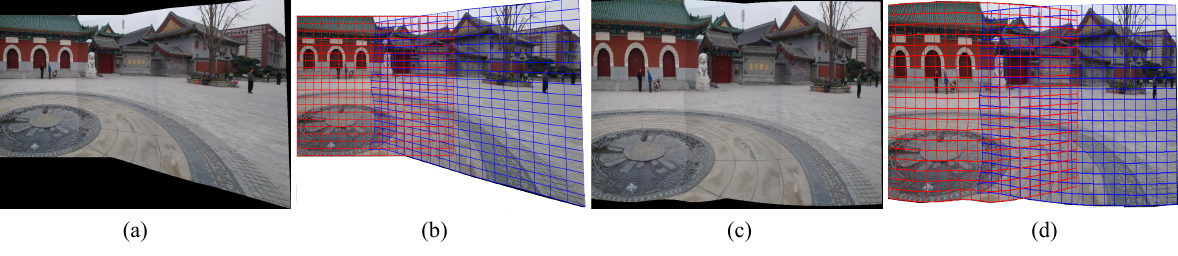
Figure 4. (a)-(b) APAP warping. (c)-(d) our